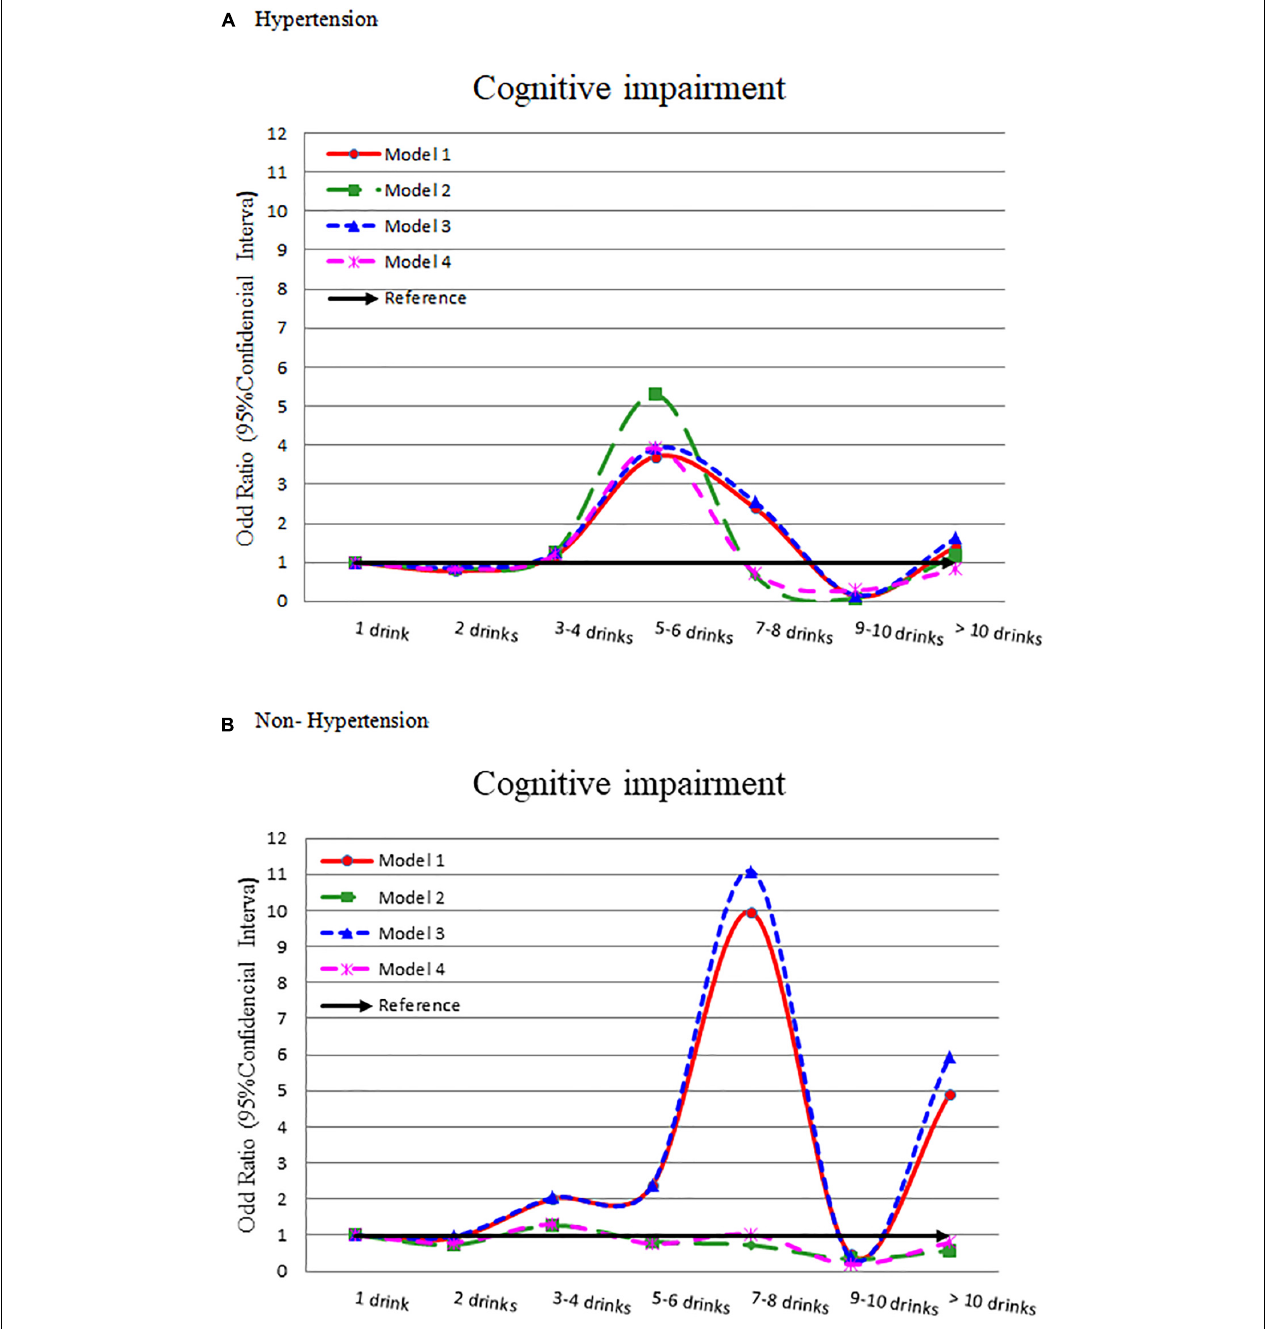
FIGURE 2 | Odds ratio for cognitive impairment by different alcohol consumption categories-stratified by hypertension. (A) With hypertension and (B) without hypertension. Model 1: crude OR (95%CI). Model 2: adjusted for demographic variables. Model 3: adjusted for comorbidity variables. Model 4: adjusted for the significant variables in Supplementary Table 5